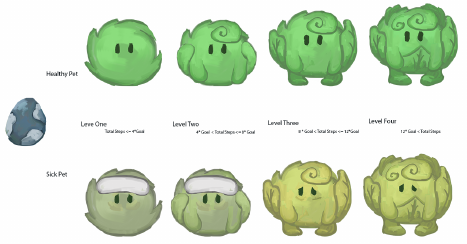
Figure 3 . The Growth Levels and Health Conditions of the